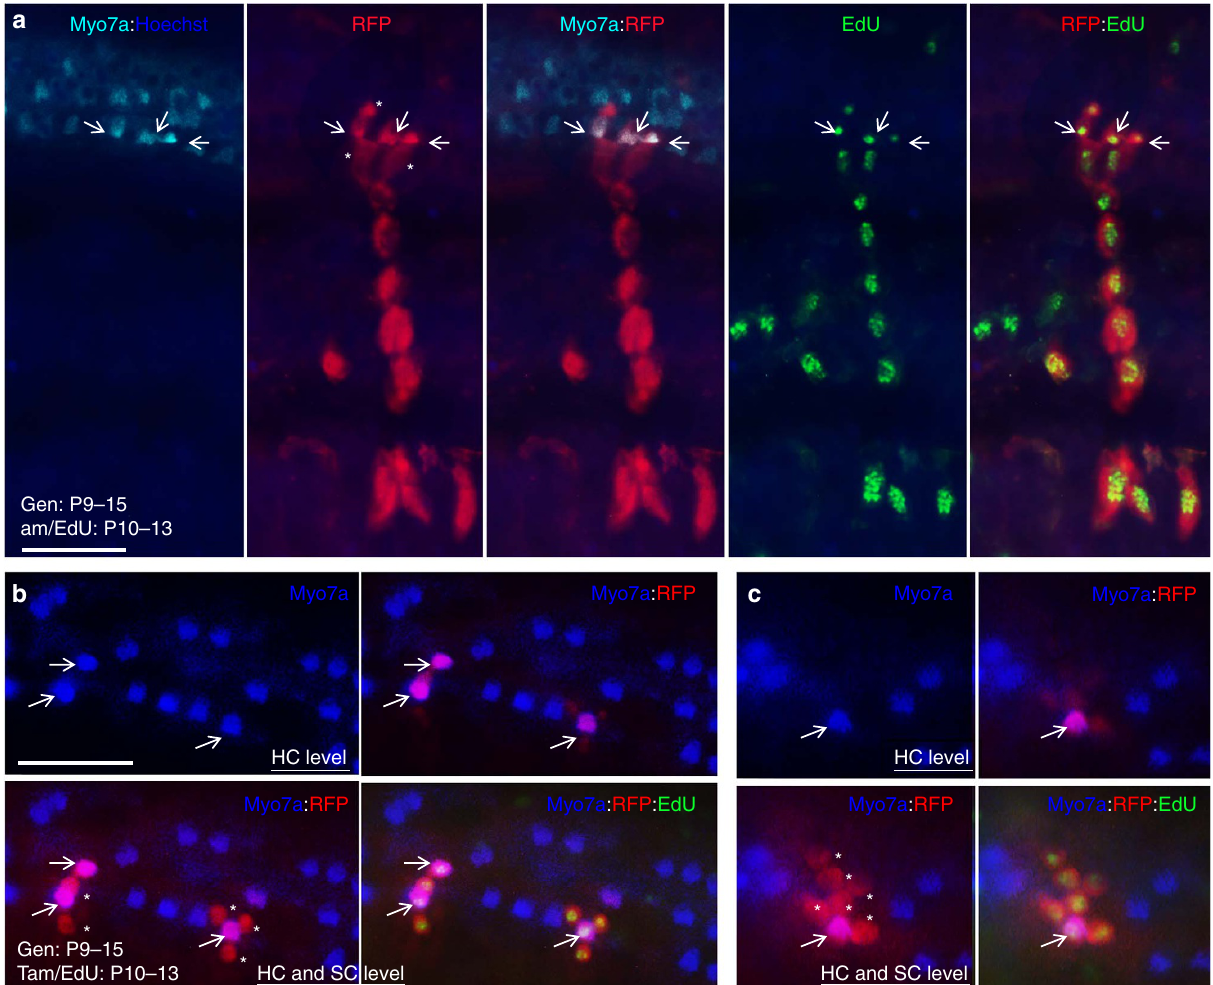
Figure 9 | Mitotic hair cell regeneration in postnatal cochlea beyond 1 week of age. P20 Rosa CreER ;Rainbow cochleae treated with gentamicin from P9 to P15 and tamoxifen/EdU from P10 to P13. ( a ) Merged images showing EdU incorporation (green) in all marked individual cells within a red clonal cluster consisting of Myo7a þ HCs (blue, arrows) and surrounding SCs and their associated spiral ganglion cells. ( b , c ) Images showing incorporation of EdU (green) in all marked individual cells within red clonal clusters consisting of Myo7a þ HCs (blue, arrows) either separated or surrounded by Myo7a (cid:2) SCs (asterisks) within the sensory epithelium. Scale bars: 30 m